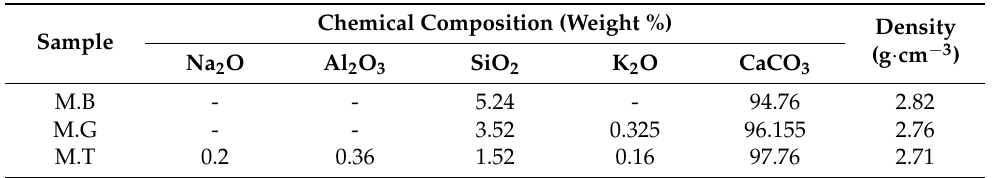
Table 2. Chemical composition of the marble